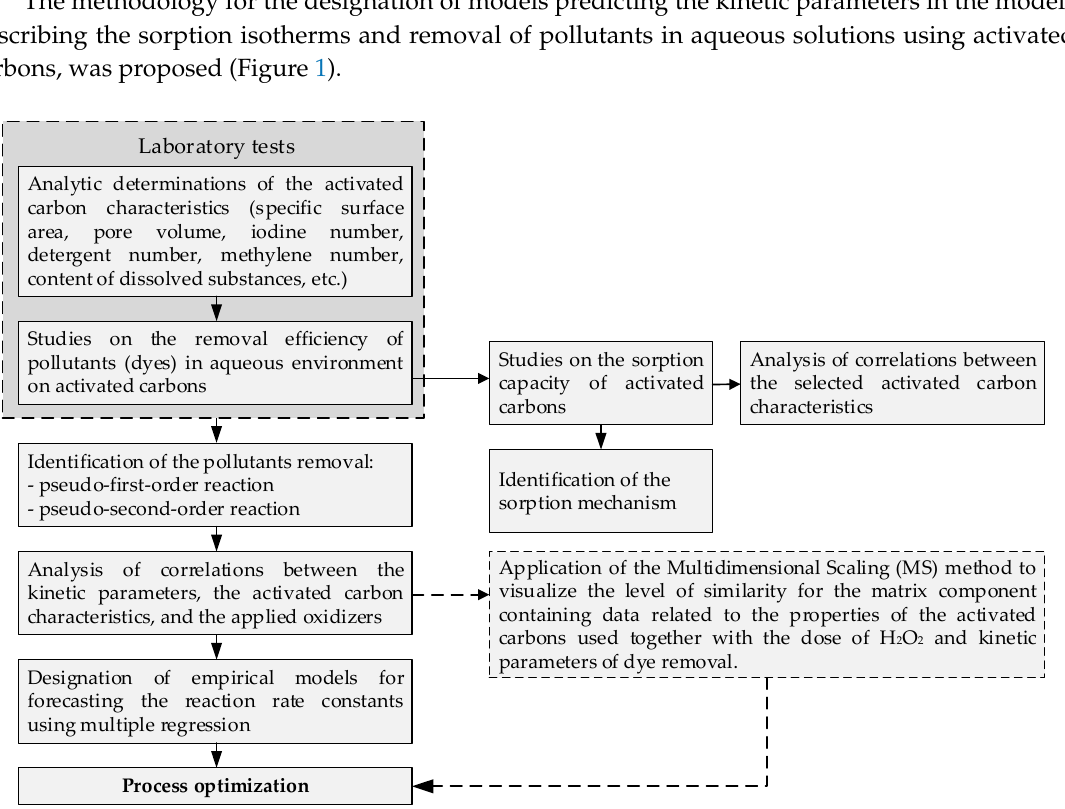
Figure 1. Algorithm for the creation of a model predicting the kinetics of sorption and pollutant removal.